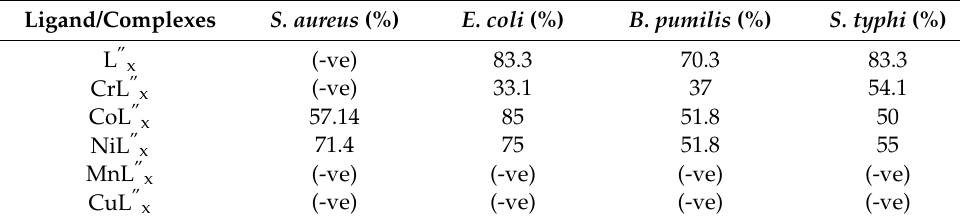
Table 6. Antibacterial Activities of Compound 3 – 8